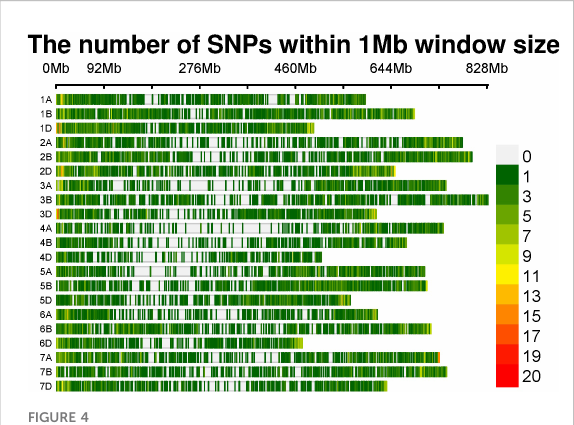
FIGURE 4 SNP density plot indicating the distribution of fi ltered SNPs across chromosomes.